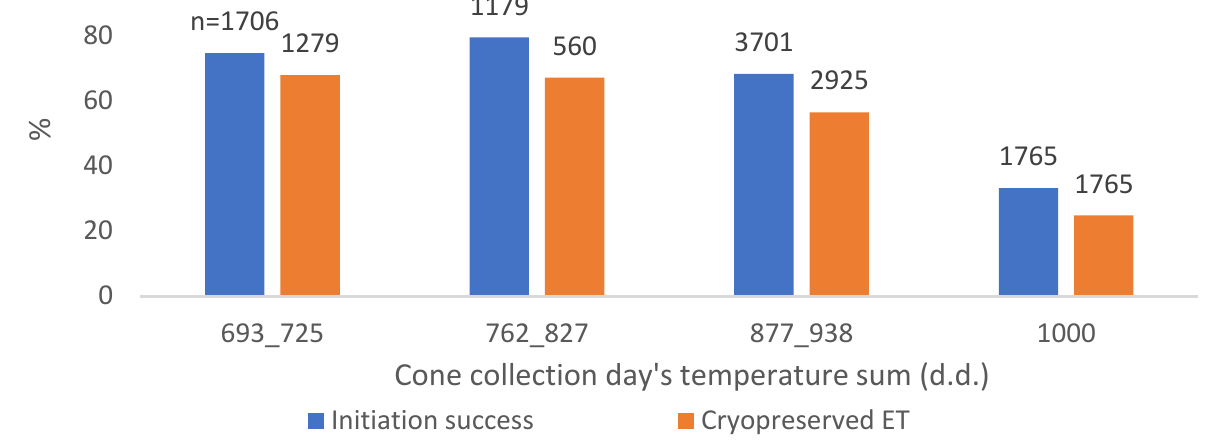
Figure 2. Norway spruce SE initiation success percentages from 2011 to 2022, and the percentage of initiations which led to cryopreservation from 2014 to 2022 in different cone collection days’ temperature sums (d.d.).